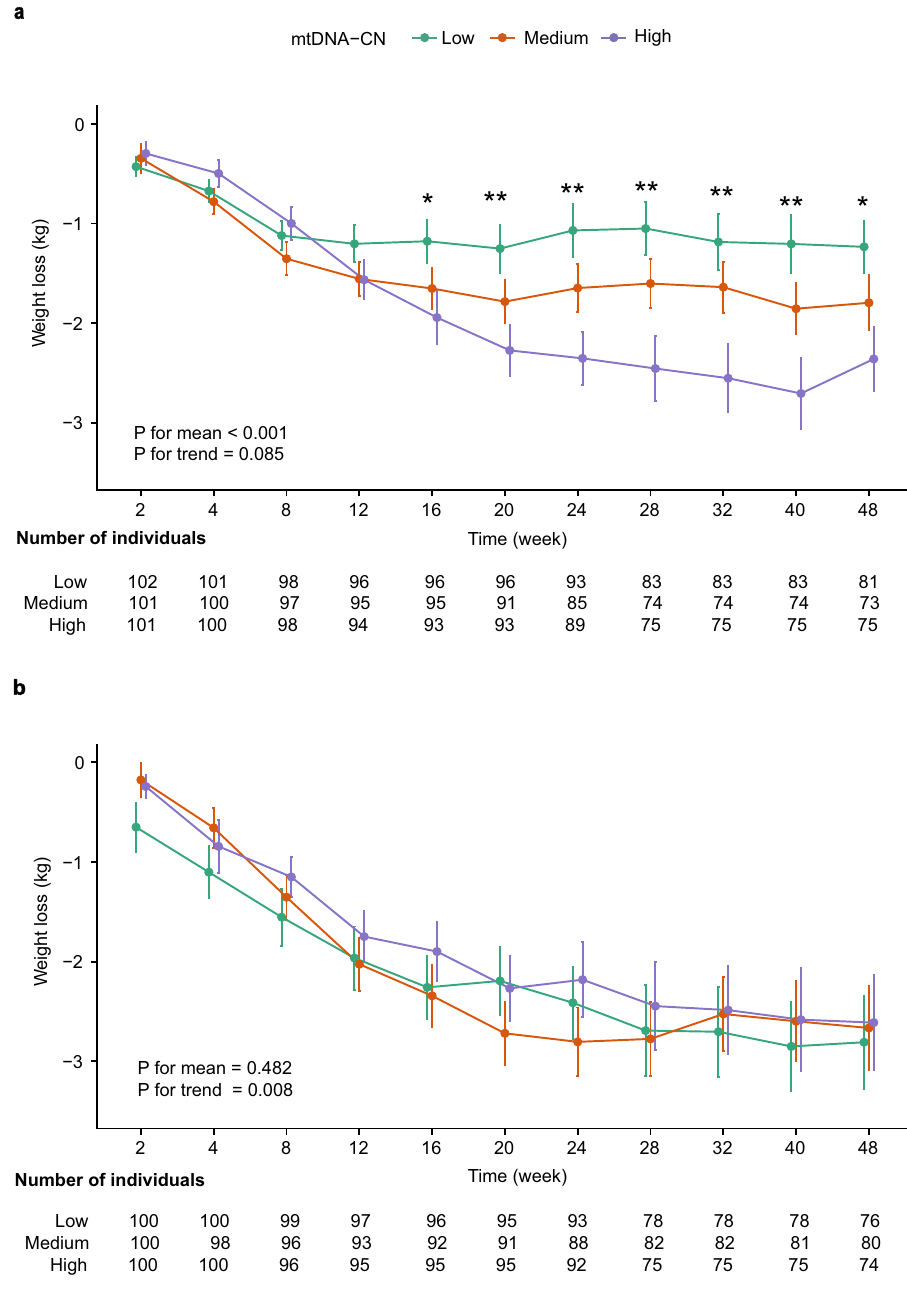
Fig. 1 Weight loss by mitochondrial DNA copy number (mtDNA-CN) terciles at multiple time points for two drug treatment arms. a Metformin treatment arm. b Acarbose treatment arm. Error bars were standard error of the mean. Participants were evenly strati fi ed into low (green), medium (orange), and high (purple) groups according to standardized mtDNA-CN level. * P < 0.05, ** P < 0.01, P for three tertiles differences at 16 week ( P = 0.038), 20 week ( P = 0.006), 24 week ( P = 0.001), 28 week ( P = 0.002), 32 week ( P = 0.005), 40 week ( P = 0.003), 48 week ( P = 0.018) at metformin treatment arm. P for mean: Repeated measurement analysis examined differences in the mean weight loss among three mtDNA-CN groups between 16 and 48 weeks of monotherapy in patients. P for trend: Repeated measurement analysis examined changes in weight loss over time between 16 and 48 weeks of monotherapy in